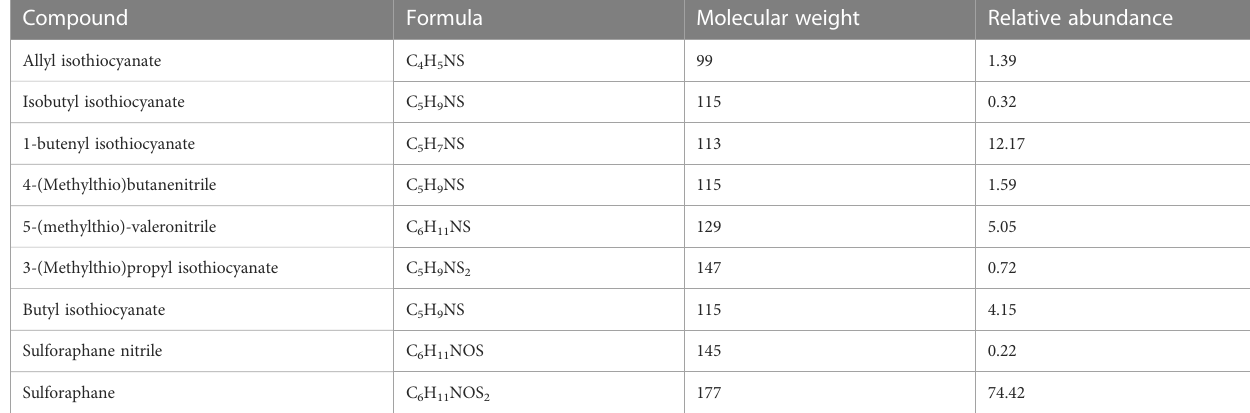
TABLE 2 Enzymatic hydrolysates of glucoraphanin.